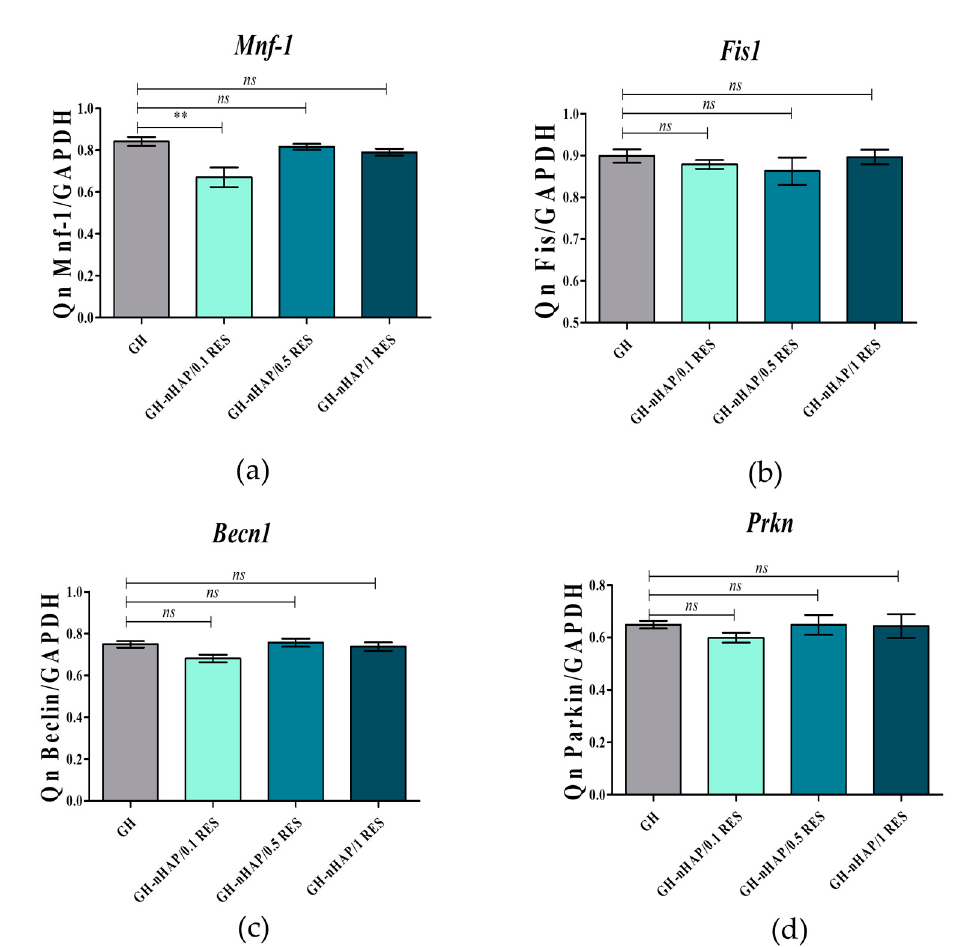
Figure 11. The mitochondrial fusion gene expression of mitochondrial fusion ( a ), mitochondrial fission 1 protein ( b ), Beclin-1 ( c ), and Parkin ( d ) in hASCs. Statistically significant changes are indicated with asterisks; (**) p < 0.01, while non-significant differences are marked as ns .